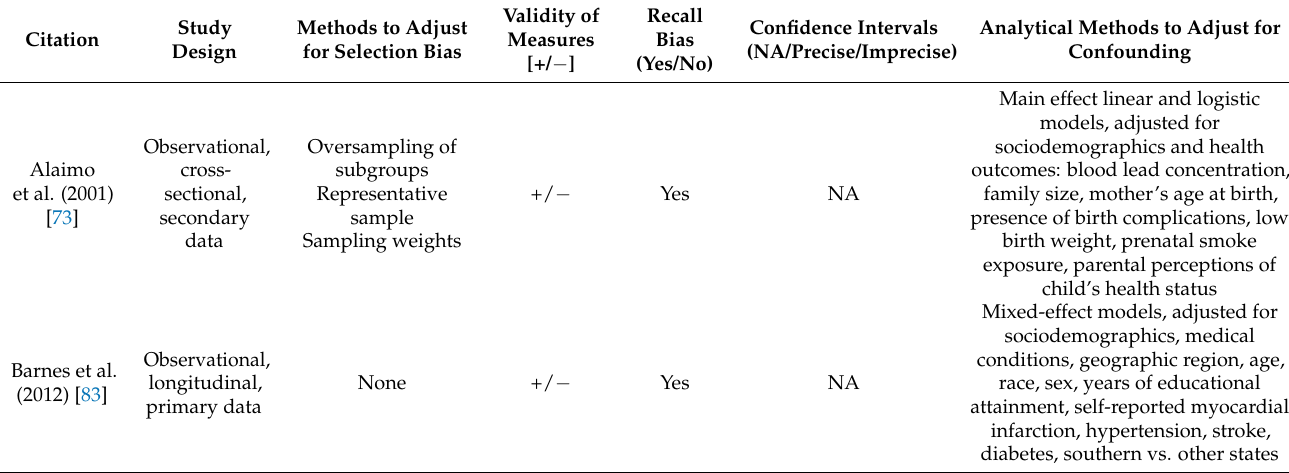
Table 3. Research methodology, study design, biases, measurement validity, and analytical